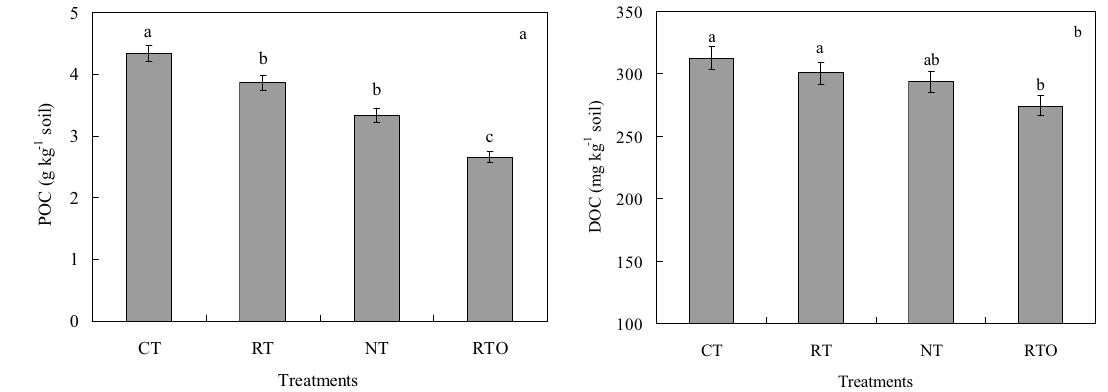
Figure 1. Effects of different tillage management on soil particulate organic carbon (a) and dissolved organic carbon (b) contents in a double-cropping rice field. CT conventional tillage with crop residue incorporation; RT rotary tillage with crop residue incorporation; NT no-tillage with crop residue retention; RTO rotary tillage with crop residue removed as a control. Error bars represent standard error of mean. Different smaller letters were indicated significant difference at p < 0.05 level.